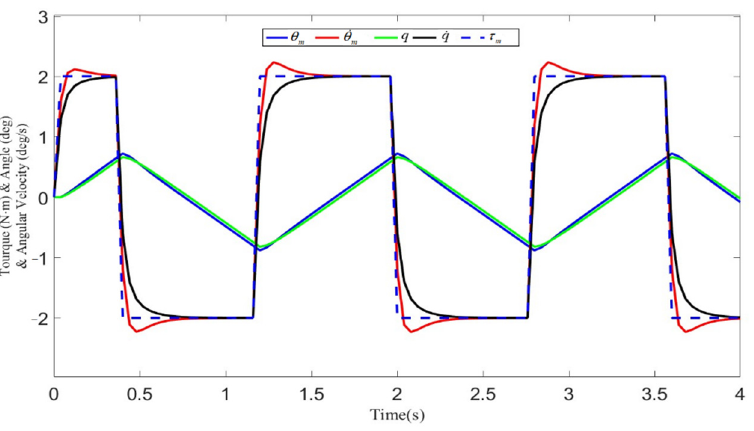
Figure 4. Virtual flexible joint velocity-tracking response.